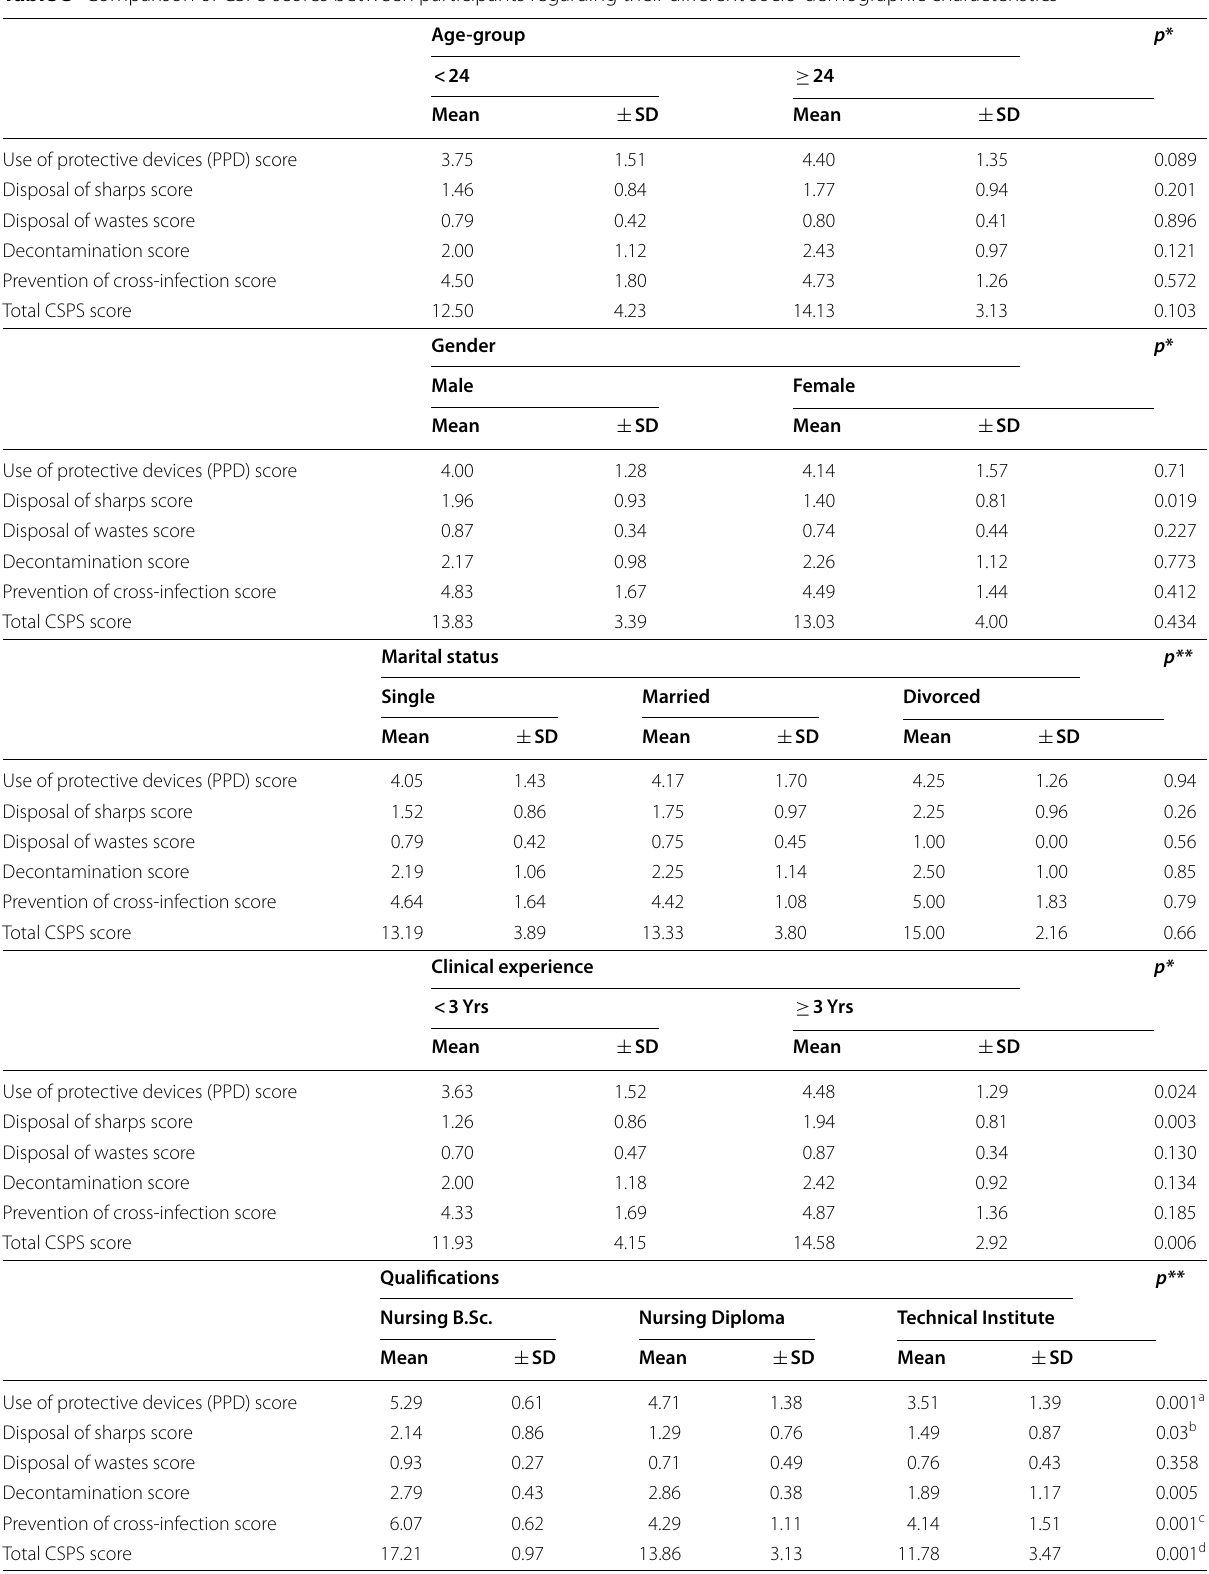
Table 3 Comparison of CSPS scores between participants regarding their different socio-demographic characteristics Age‑group p * <